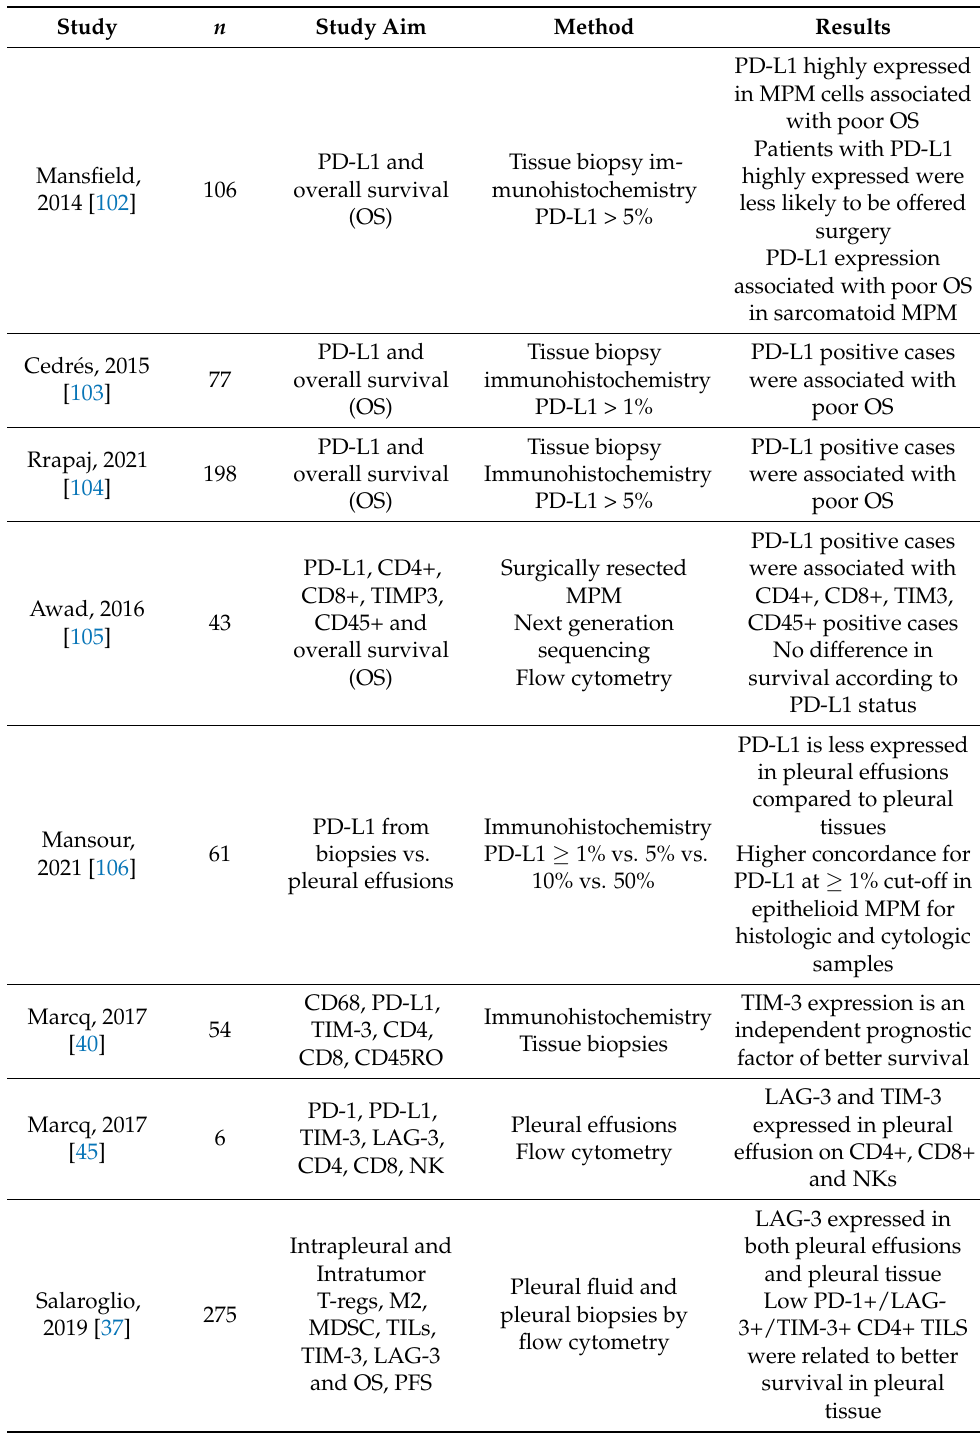
Table 4. Studies with immune checkpoints expression in